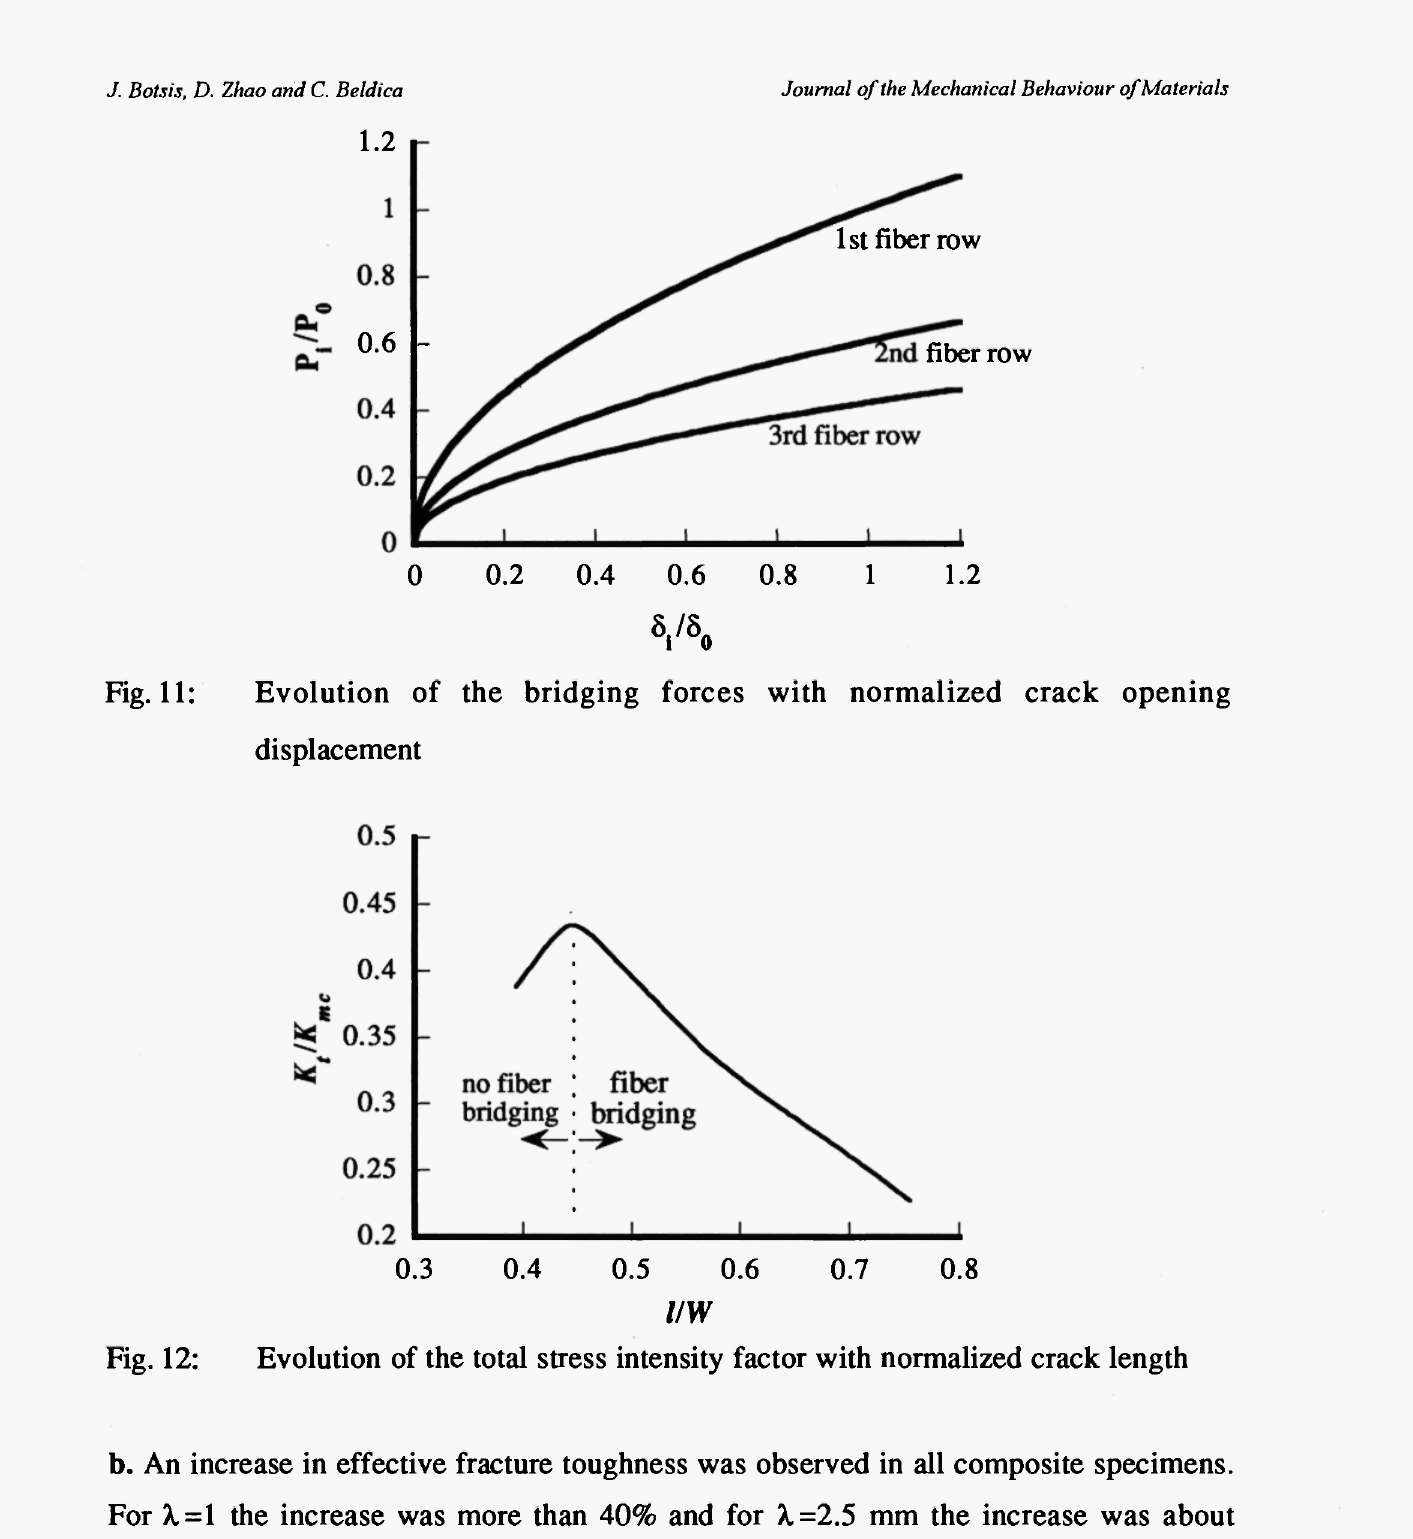
Fig. 12: Evolution of the total stress intensity factor with normalized crack